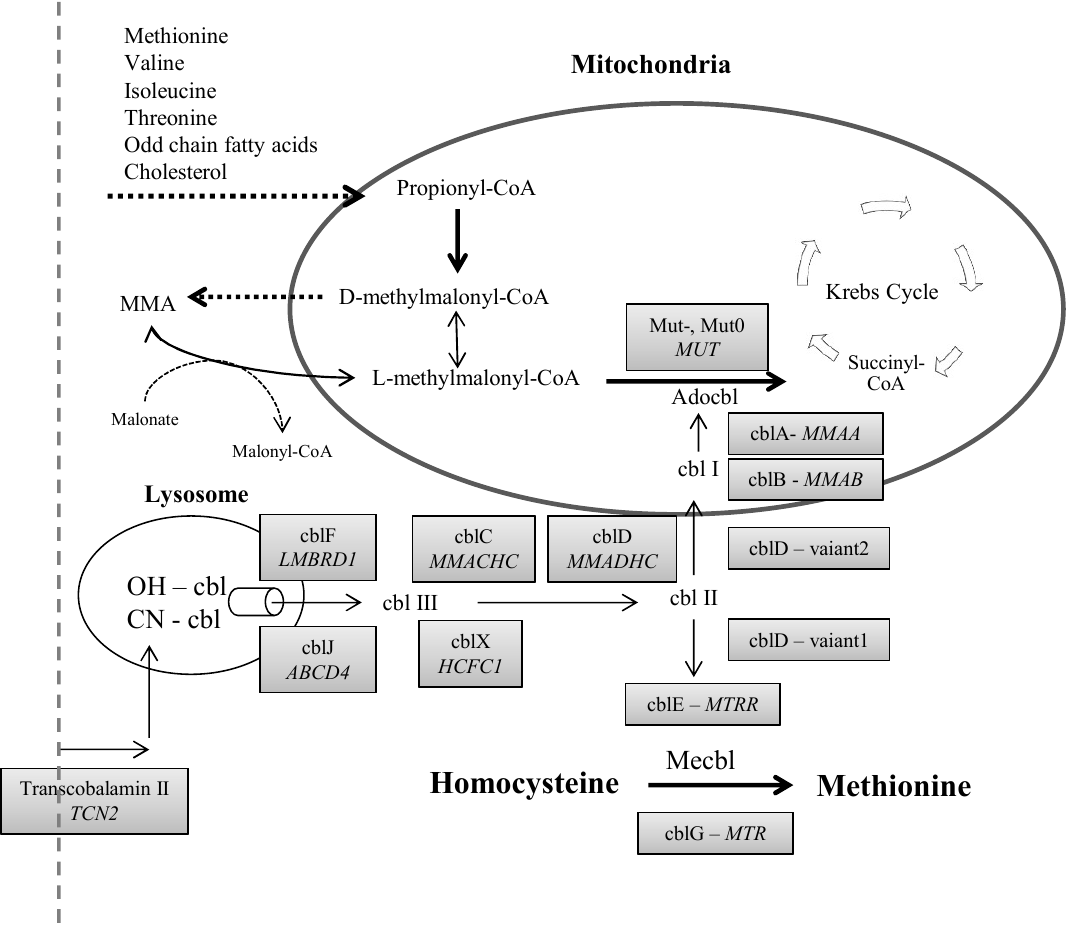
Figure 2. Overview of B12 metabolism. MMA: methylmalonic acid; MUT: methylmalonyl CoA mutase; Mut -: partial loss of MUT function; Mut 0: complete loss of MUT function; Adocbl: adenosylcobalamin; cbl: cobalamin; MMAA: Methylmalonic aciduria type A; MMAB: Methylmalonic Aciduria cblB Type; MMADHC: methylmalonic aciduria and homocystinuria type D; MMACHC: methylmalonic aciduria